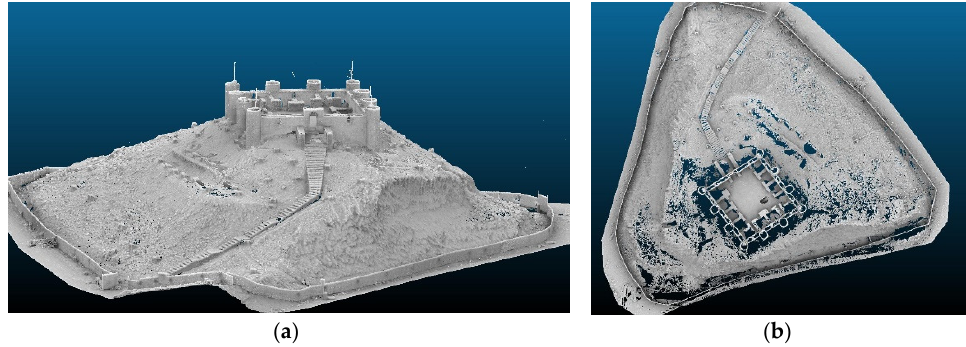
Figure 13. ( a ) Three-dimensional point cloud using TLS. ( b ) Unsampled roofs and upper parts obscured from TLS.